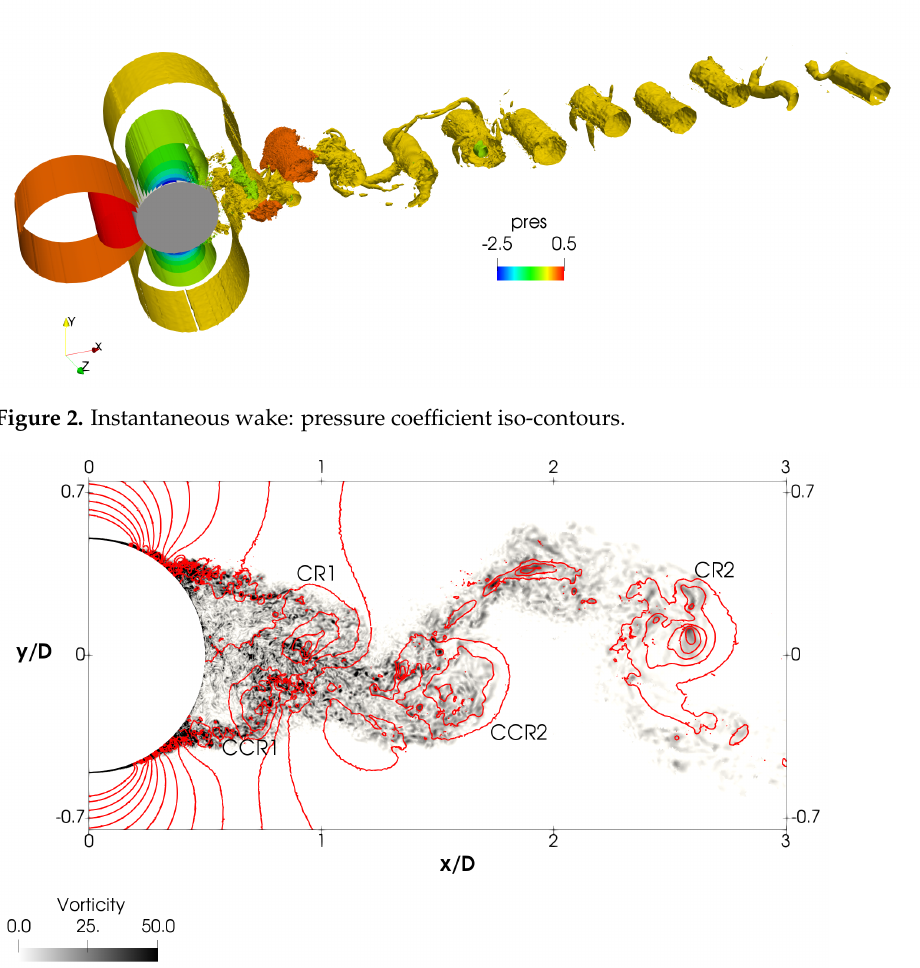
Figure 3. Instantaneous vorticity magnitude superimposed with pressure coefficient iso-contours (red) in the vortex formation